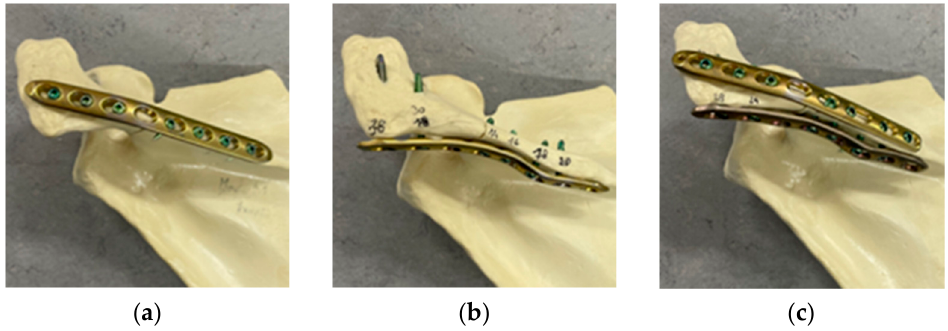
Figure 2. Three plating methods were investigated: ( a ) LCP placed below spina scapulae (LCPcaudal), ( b ) LCP placed on backside of spina scapulae (LCPdorsal), and ( c ) a double plating approach (LCPdouble). To minimize unwanted variation in fracture care or plate positioning and to ensure